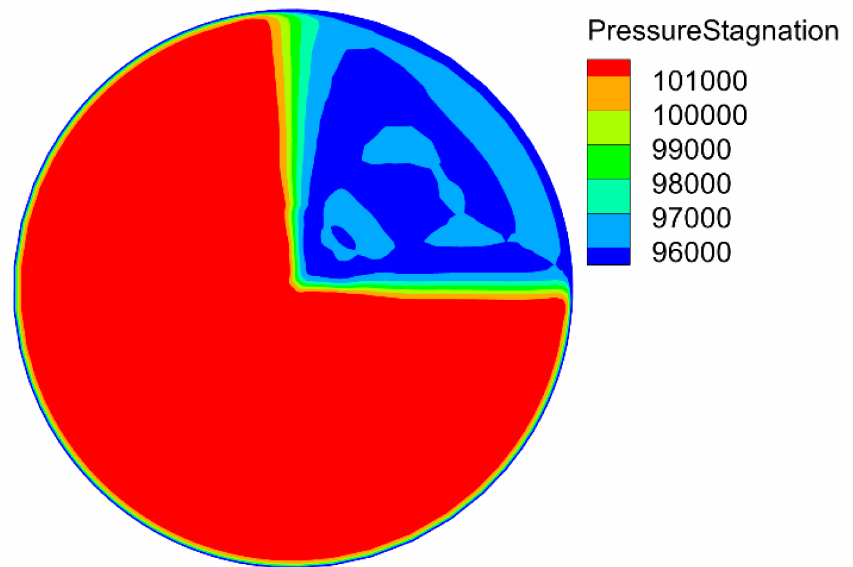
Figure 13. Total pressure distribution at the inlet AIP.